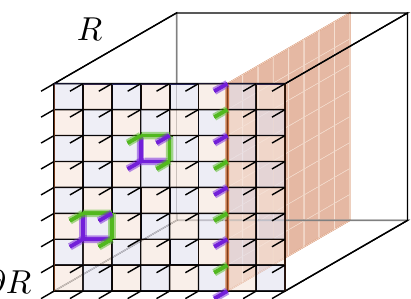
FIG. 12. Topological boundary states for the six-ring fusion network. By fusing resource states in a region R , we are left with a series of unmeasured, outer qubits on the boundary ∂ R (repre- sented by short lines coming out of the page). These outer qubits are in a code state of the surface code (up to signs depending on measurement outcomes), as can be inferred from the surviving stabilizers XZZX ⊗ s inner depicted. Therein, short purple (green) lines correspond to Pauli- X (Pauli- Z ) operators, while long pur- ple (green) lines correspond to XX ( ZZ ) operators. Another type of surviving stabilizer Z ⊗ s inner is depicted, where Z is a logical operator for the surface code on ∂ R and s inner is supported on a two-dimensional membrane.